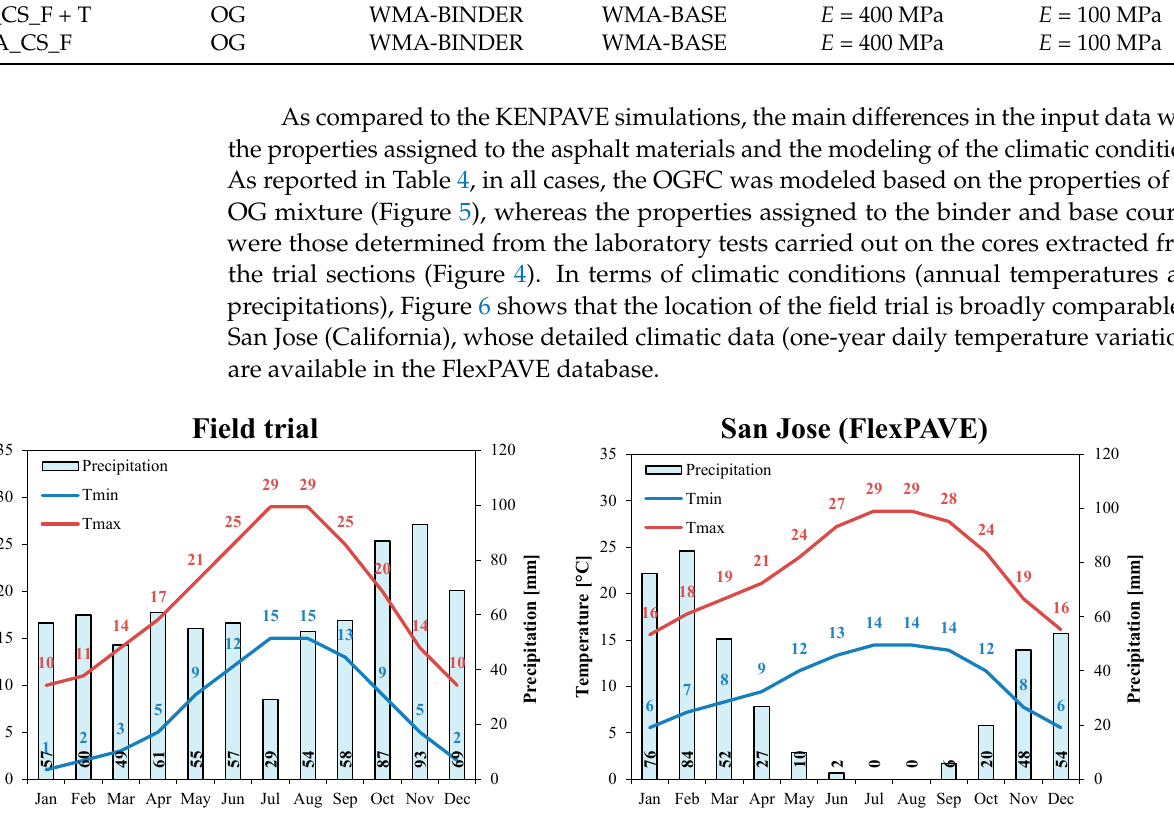
Table 4. Material properties considered in the FlexPAVE simulations.